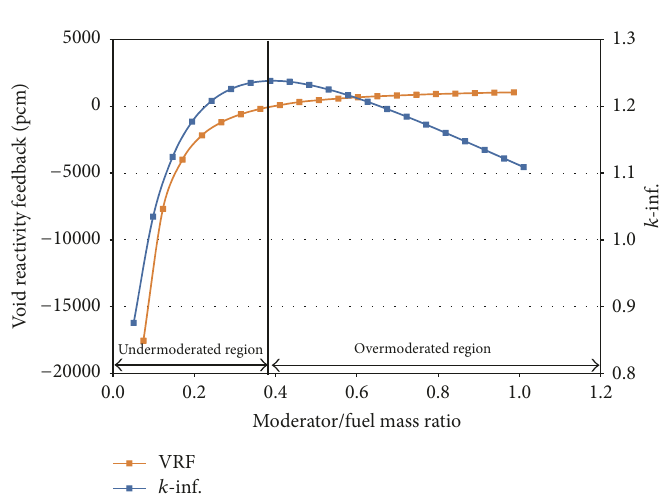
Figure 3: Multiplication factor and VRF over the moderator/fuel